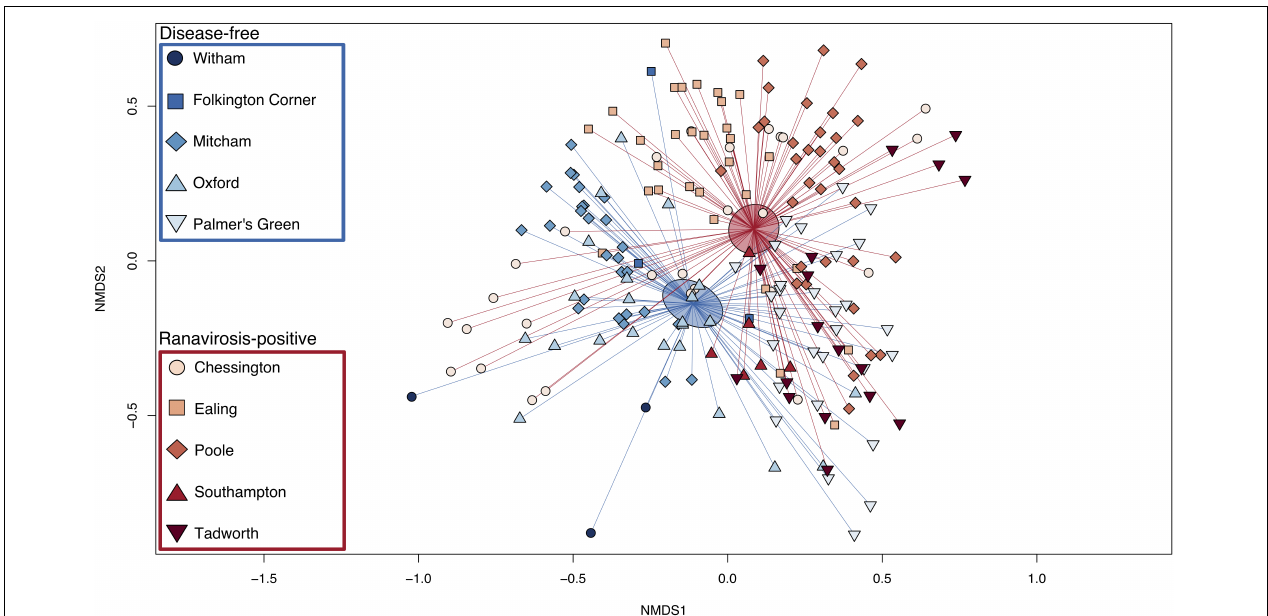
FIGURE 3 | Bray-Curtis NMDS plot of skin microbiome similarity. The microbial community of each individual R. temporaria is represented by a point. The shape of the point differentiates individuals from different populations. Ranavirosis-positive populations are shown in red hues and disease-free populations in blue hues. Each point is connected to the averaged point (centroid) of microbial community structure for its respective disease history group. Shaded ellipses represent the 95% confidence interval around the disease history group